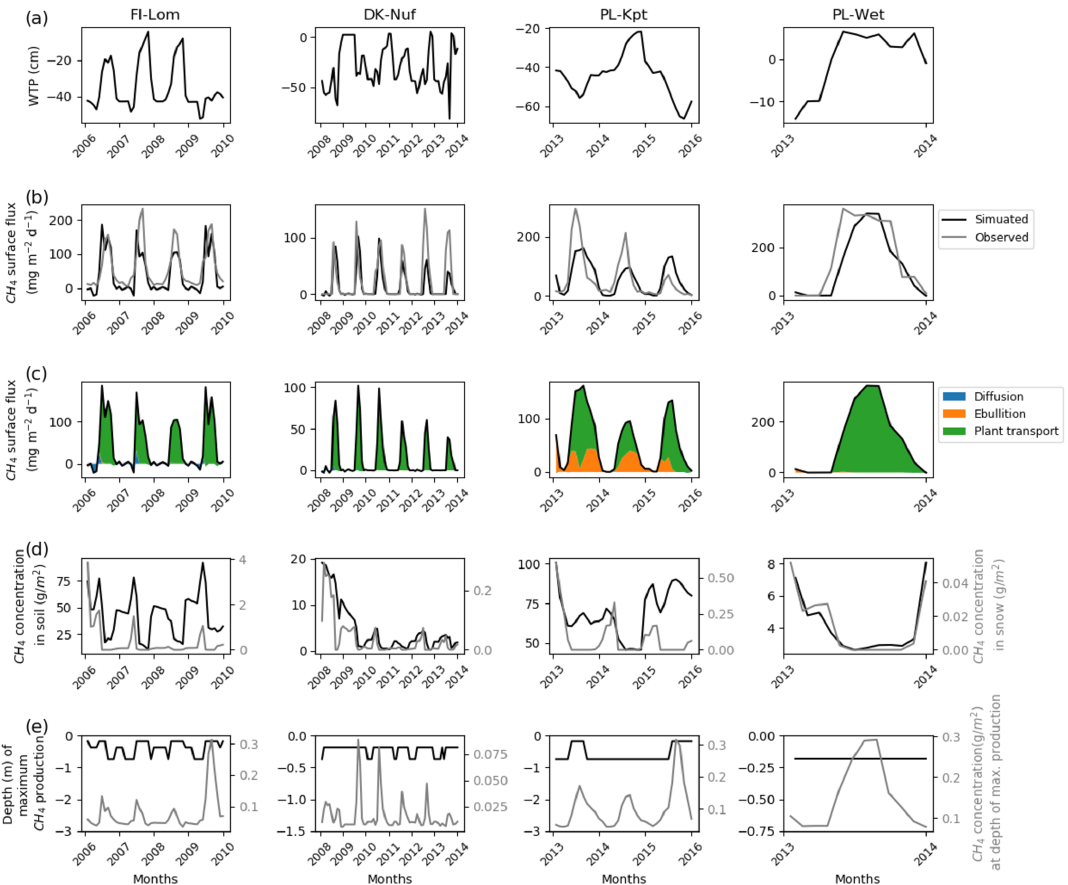
Figure 4. Temporal distribution of methane for sites emitting between 150 and 400mgCH 4 m − 2 d − 1 . (a) Simulated water table position estimated from the soil water content. (b) Simulated (dark line) and observed (gray line) methane emissions released to the atmosphere. (c) Cumulative amount of simulated methane emitted by diffusion, plant-mediated transport, and ebullition. (d) Methane concentration in the soil layers (dark line) and in the snow layers (gray line) of the model. (e) On the left is the depth at which simulated methane production is the highest in the soil, scaled to the maximum peat depth. On the right is the amount of simulated methane produced at these